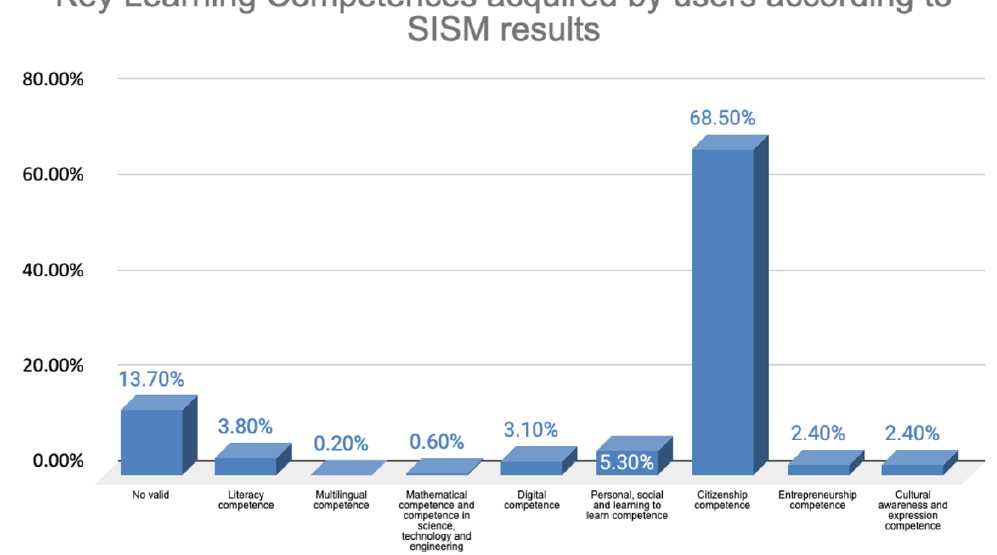
Figure 2. SISM results for “Animal Crossing: New Horizons” on